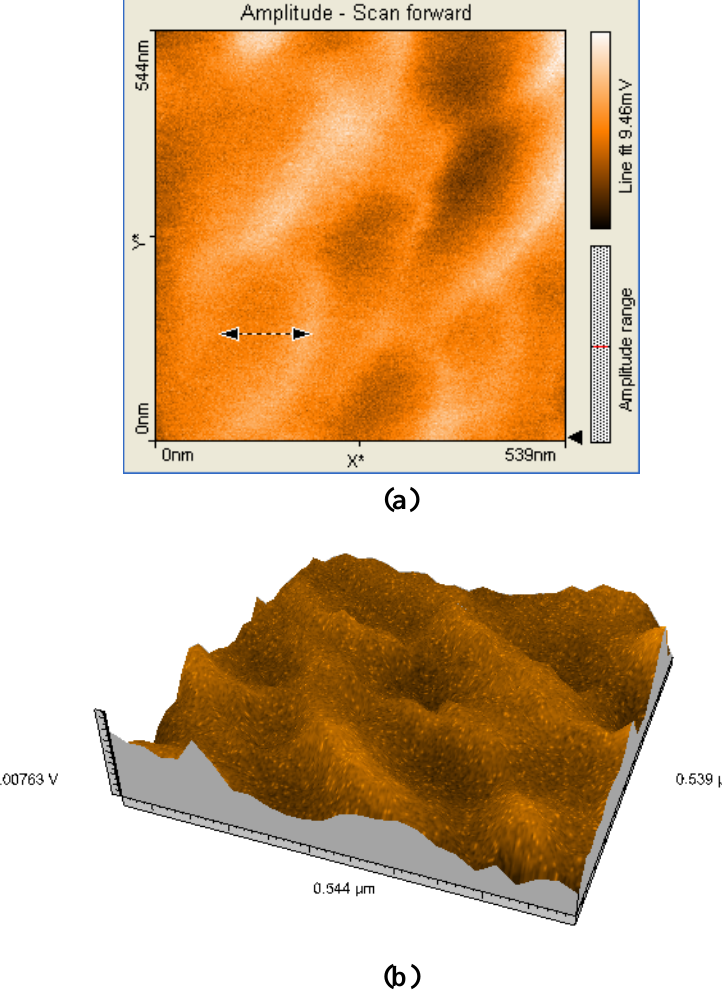
Figure 16. 2D (a) and 3D (b) AFM images (539×544nm) and particle analysis of the hybrid material 2b-AB .